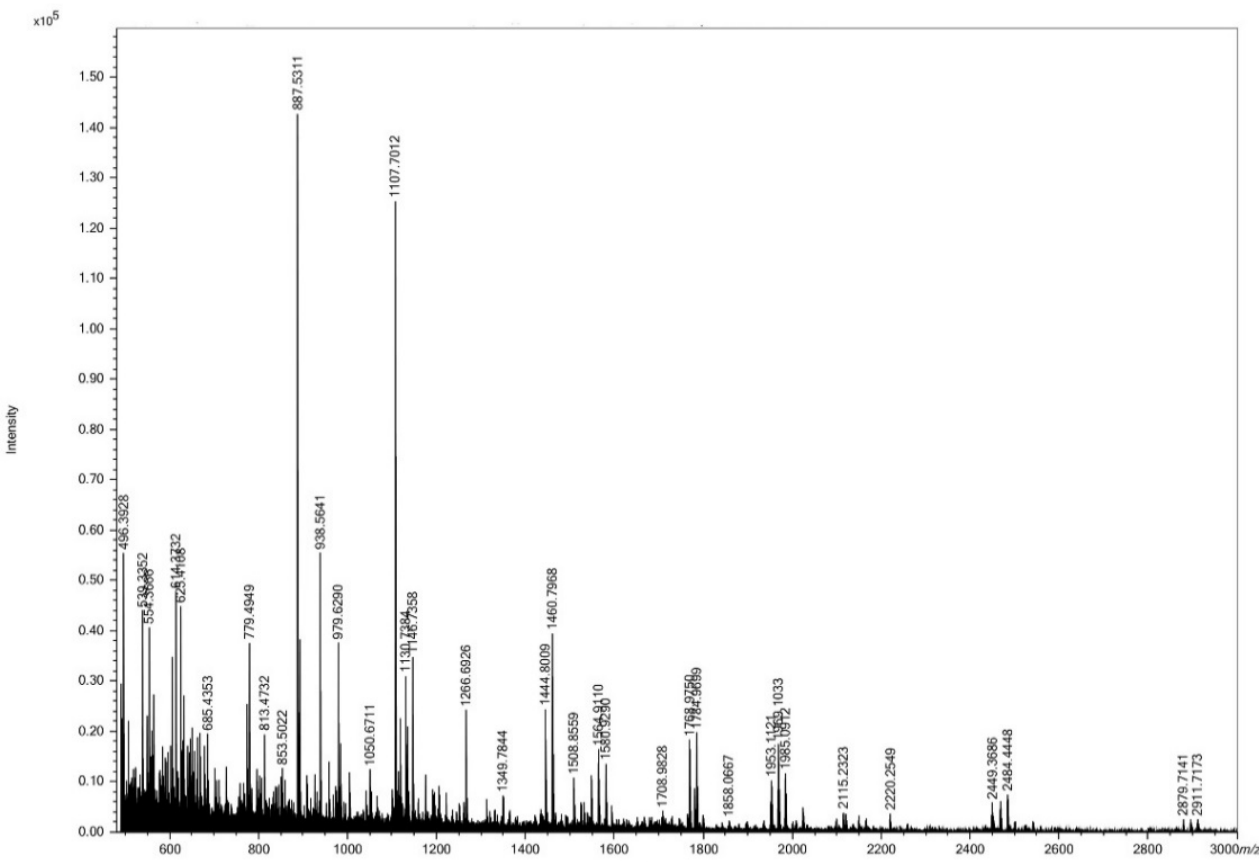
Figure 1. Size distribution of sea bass skin hydrolyzed collagen (HC) determined by MALDI-TOF mass spectrometry.